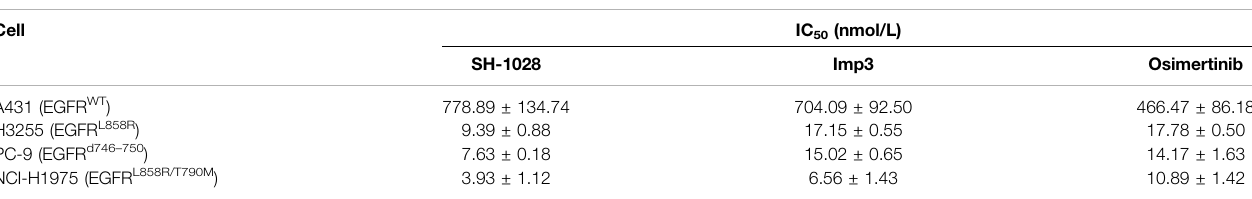
TABLE 3 | The IC 50 of compounds to cell lines ( X ± S ; n (cid:1) 3).